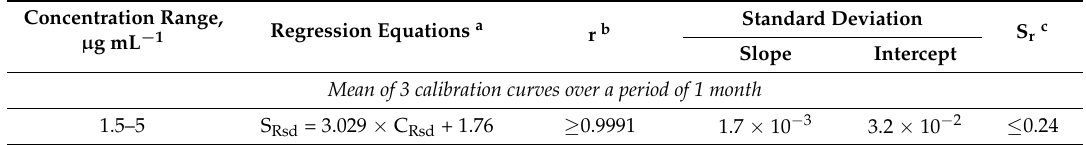
Table 1. Statistical analysis of the calibration curves of